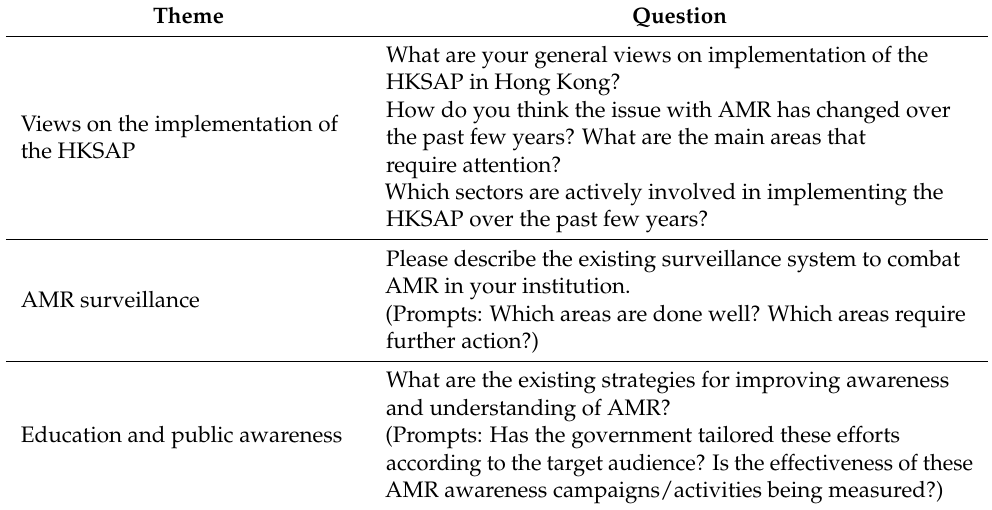
Table 1. Examples of interview questions.